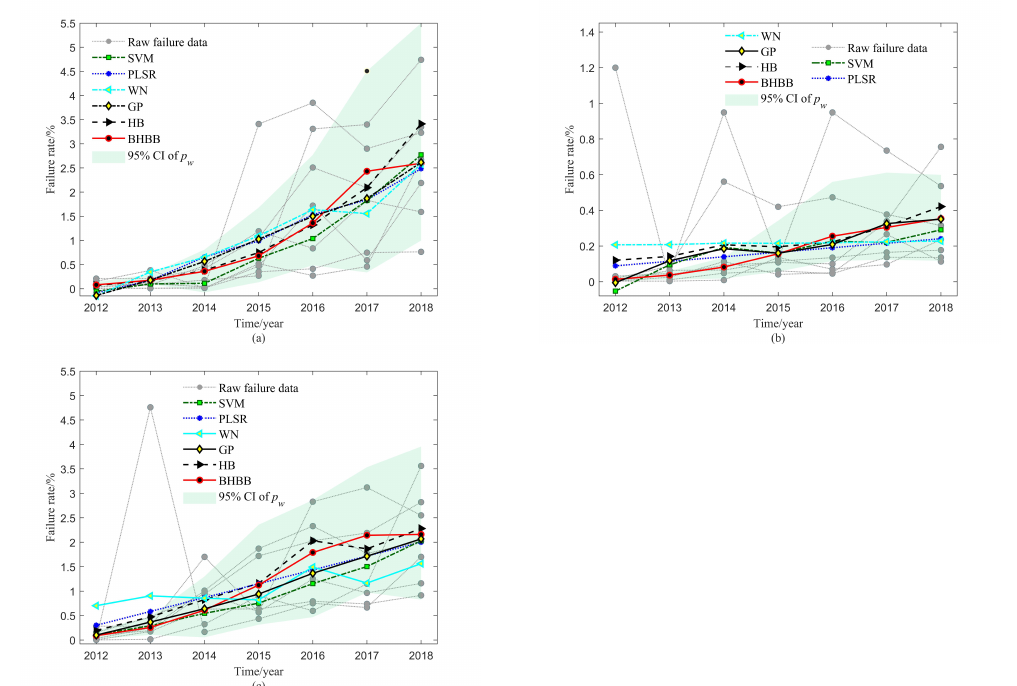
Figure 6. Failure rate prediction results of the four methods including SVM, PLSR, WN, GP, HB, and BHBB in ( a ) XZ, ( b ) XJ, and ( c )